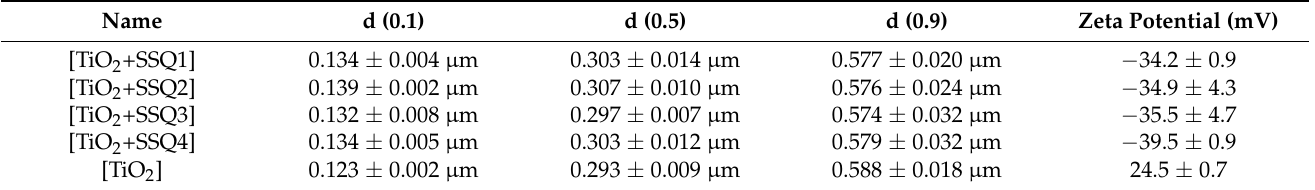
Table 4. Particle size distribution and zeta potential of nonmodified and modified titanium dioxide.